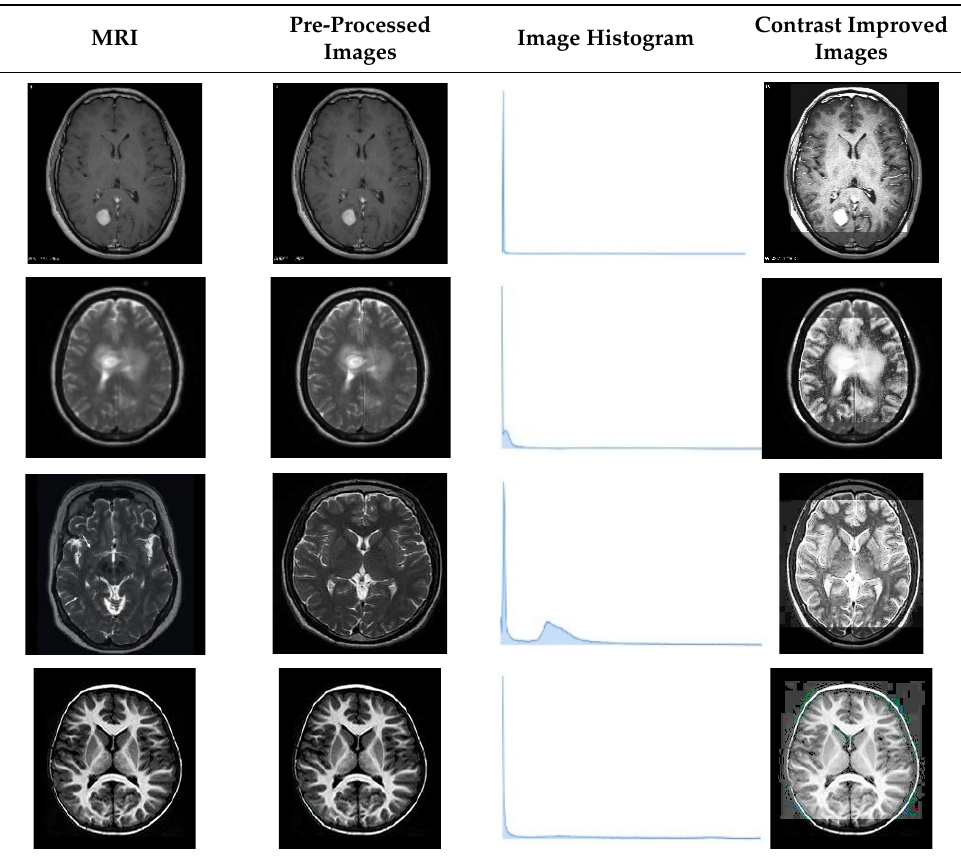
Table 1. Sample Preprocessing MRI.